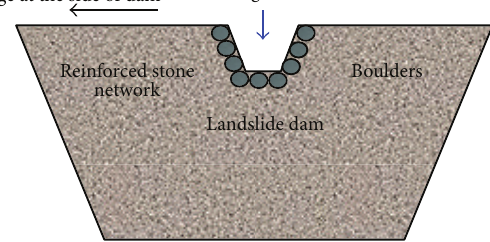
Figure 17: Suggestion for the design of a discharge channel for the emergency treatment of a landslide dam.